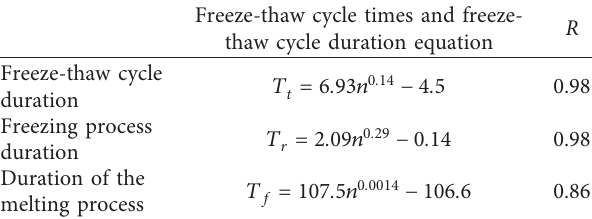
Table 2: Fitting results of the variation of tuff freeze-thaw cycle length with cycle times.